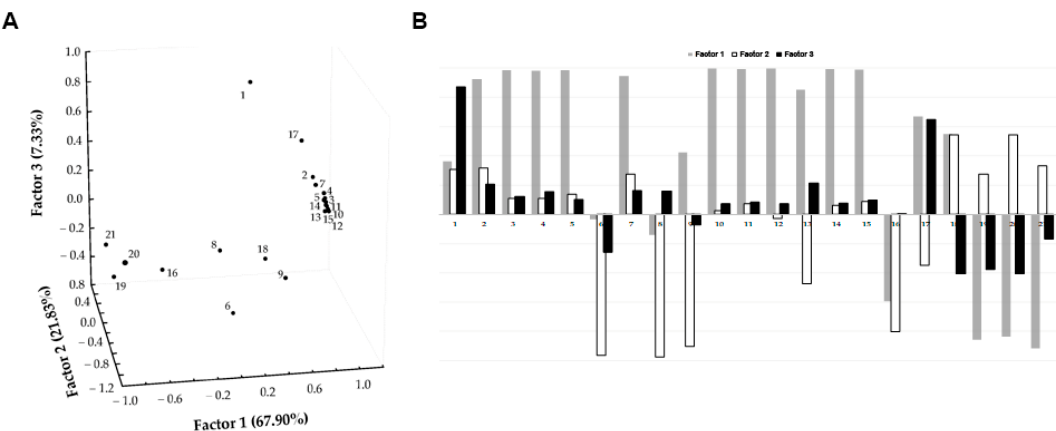
Figure 5. Factor analysis score plot ( A ) and factor loadings ( B ) relative to EVOO polyphenols and iNOS and Il-1 β data. (1) 3-hydroxytyrosol; (2) oleacinic acid; (3) oleuropein aglycone carboxylic acid; (4) oleuropein; (5) pinoresinol; (6) oleuropein aglycone enolic-aldehydic; (7) oleocanthalic acid; (8) oleuropein aglycone dialdehydic; (9) ligstroside aglycone enolic-aldehydic; (10) luteolin; (11) acetoxy pinoresinol; (12) hydroxy-methyl decarboxymethyl ligstroside aglycone; (13) ligstroside aglycone dialdehydic; (14) apigenin; (15) methoxyluteolin; (16) mono enolic-aldehydic oleuropein aglycone; (17) mono enolic-aldehydic dihydropyranic ligstroside aglycone; (18) Il-1 β RPMI; (19) Il-1 β LPS; (20) iNOS RPMI; (21) iNOS LPS.